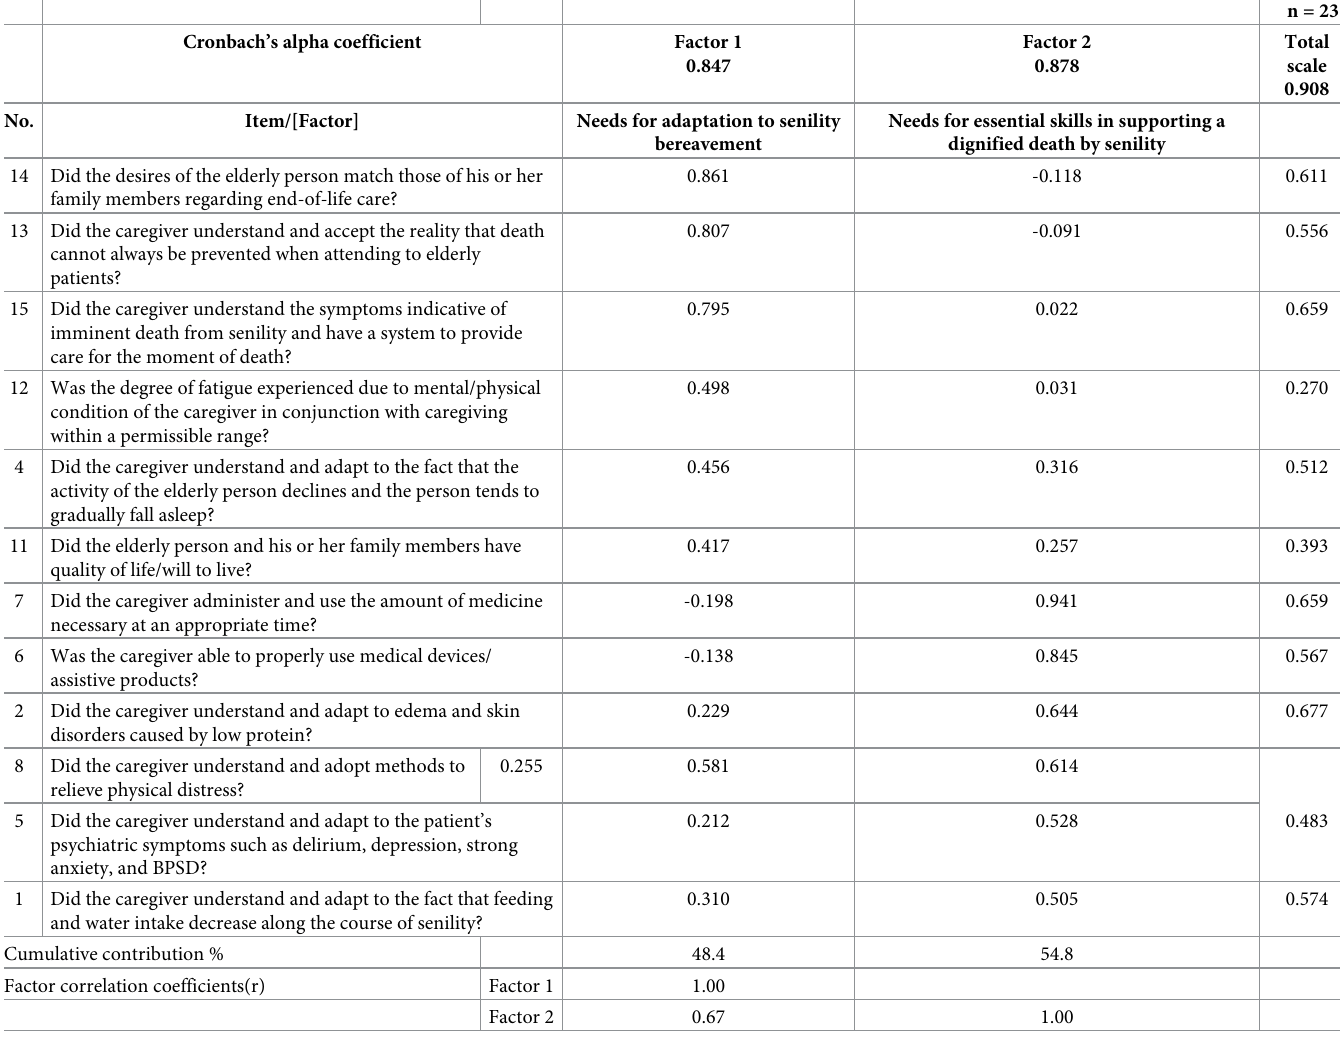
Table 4. Factor analyses of the "Family caregiver needs-assessment scale for end-of-life care for senility at home"(final